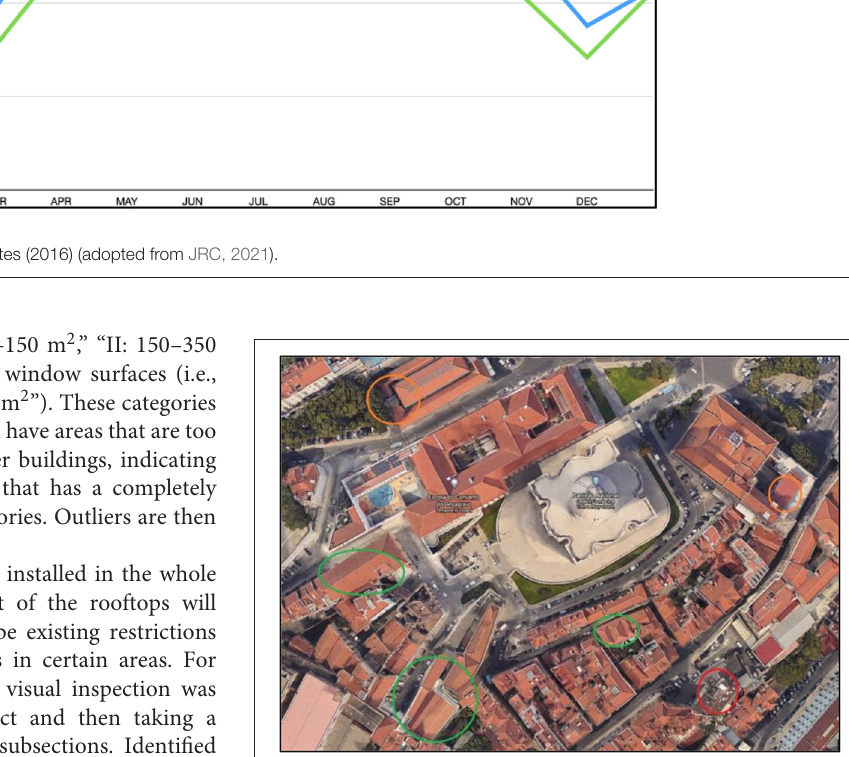
FIGURE 3 | Aerial view of the rooftop availability in the district area of São Vicente de Fora (northeast) (adopted from Google